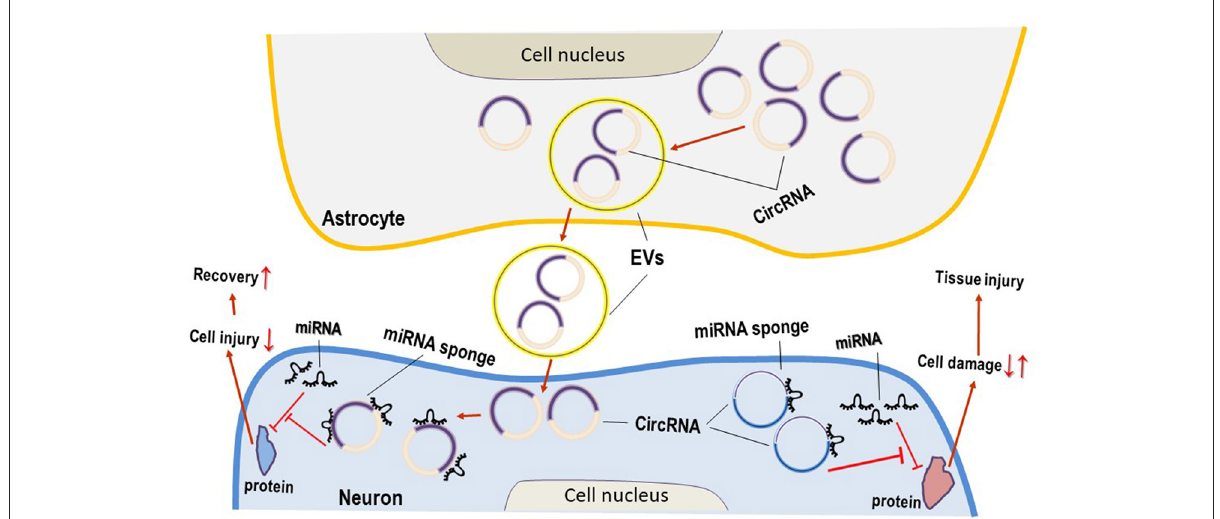
FIGURE1 Circular RNAs (CircRNAs) act as the sponges of microRNAs (miRNAs) in neuroglial damage. Main circRNAs can act as miRNA sponges, resulting in the inhibition of miRNA on its target genes and/or proteins, and function as important roles in neuronal damage. Some circRNAs derived from extracellular vesicles (EVs) in astrocytes are beneficial for the attenuation of neurological